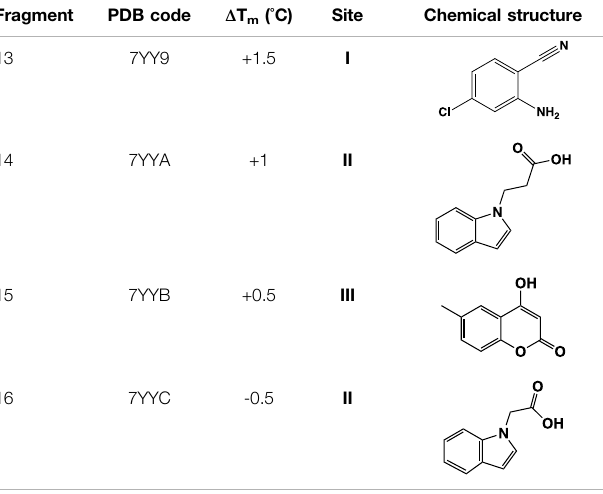
TABLE 1 | ( Continued ) Summary of fragment hits identi fi ed on M. abscessus PPAT shown along with corresponding thermal shift values and binding sites. Fragment chemical structures are also